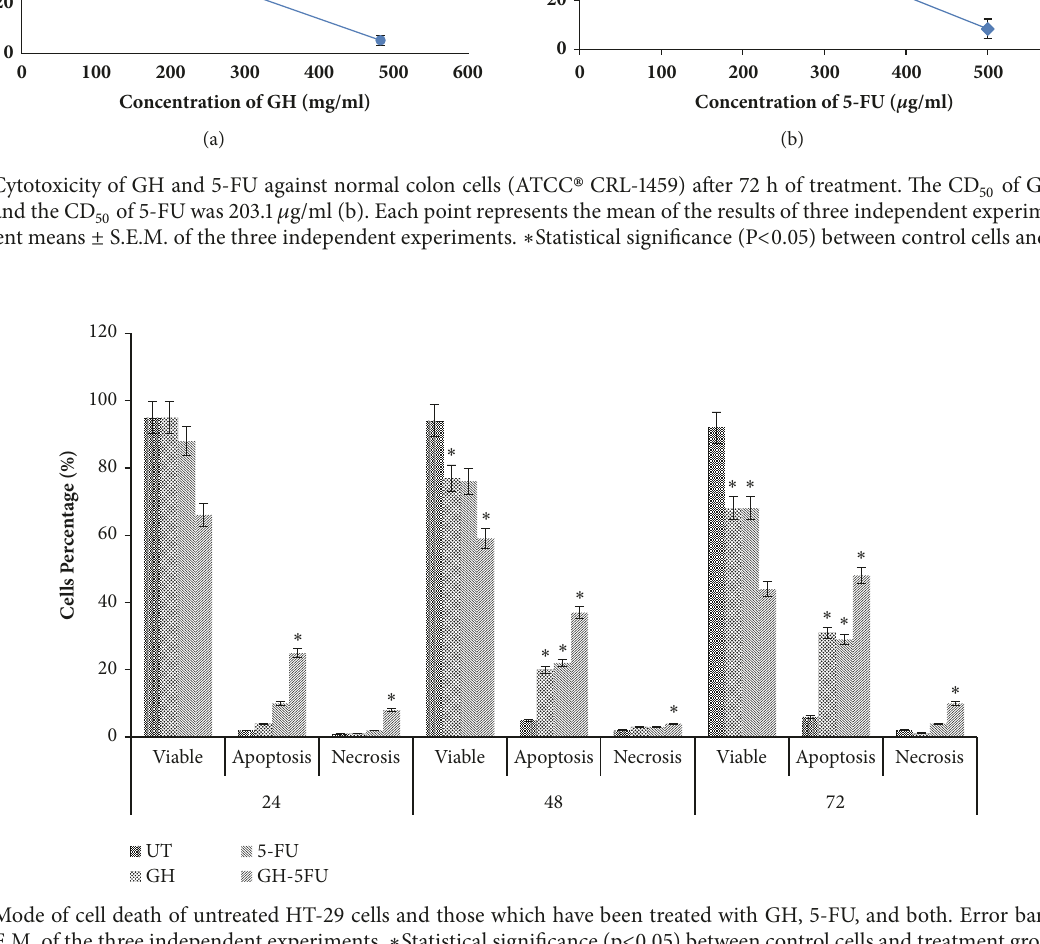
values of 25.33% at 24 h, 33.05% at 48 h, and 46.67% at 72 h.